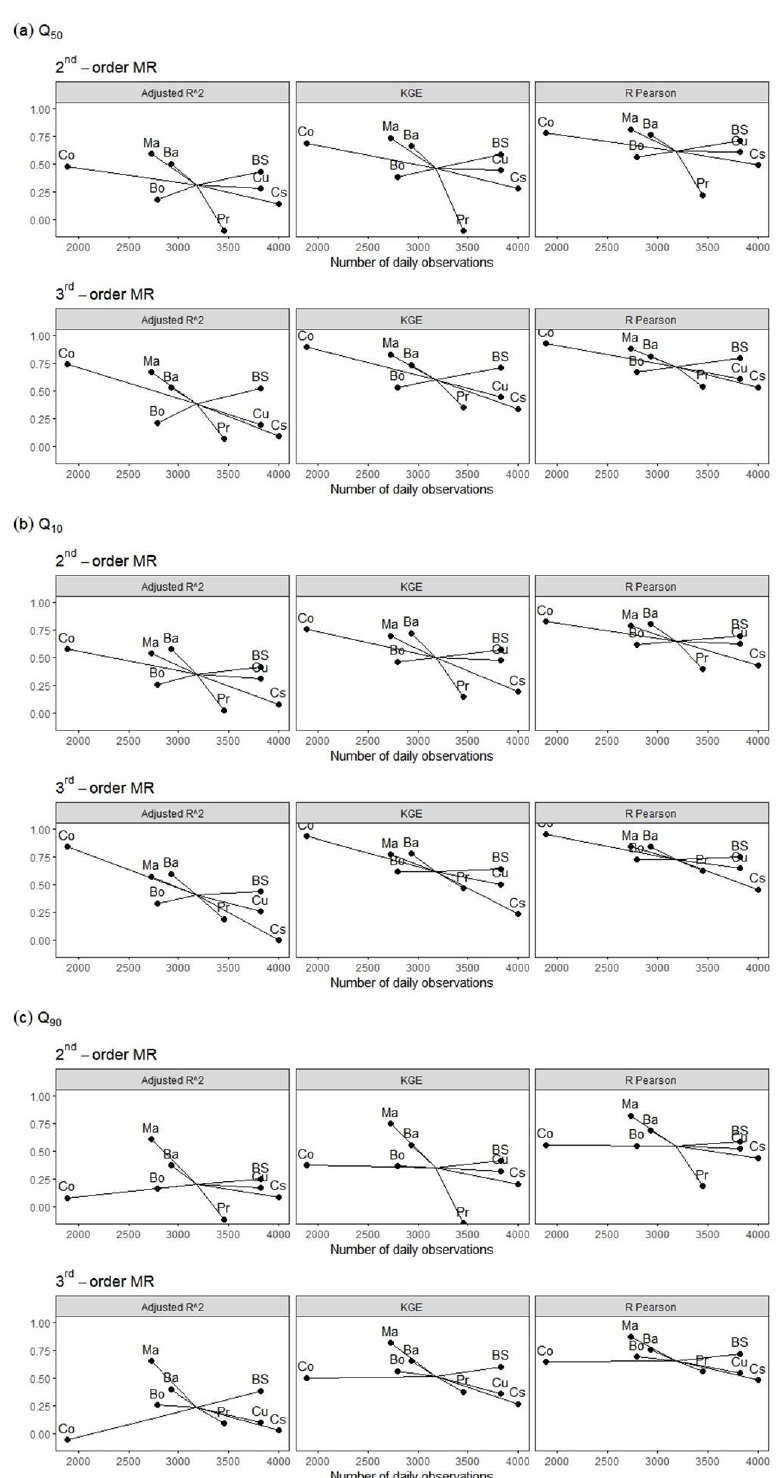
Figure A3. The number of daily observations used for developing the second- and third-order MR models of the flow regimes ( a ) Q 50 , ( b ) Q 10 , and ( c ) Q 90 in the SON a set series. The R Pearson is the coefficient correlation between predicted and observed values.